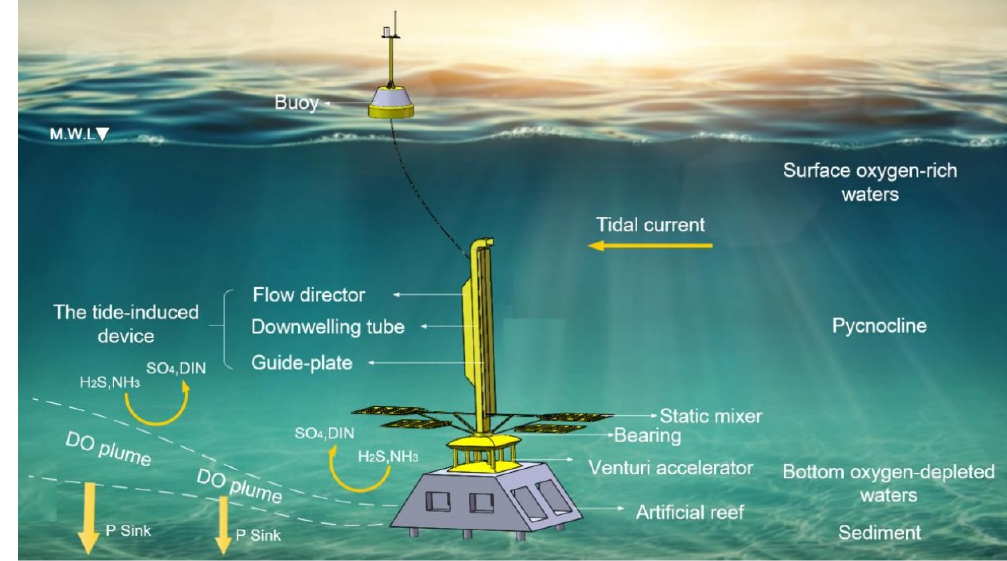
Figure 5. Sketch of the improved tide-induced device for marine ranching [54].